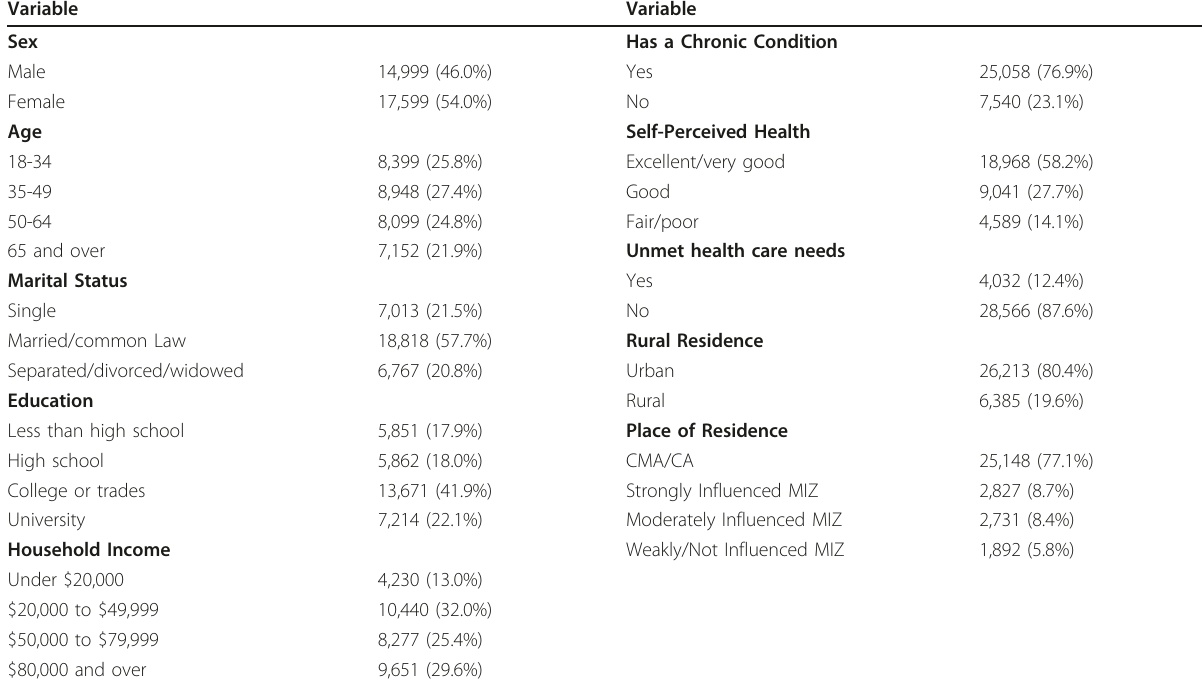
Table 5 Sample Characteristics for Independent Variables: Population aged 18 or over in Ontario (all respondents, n =